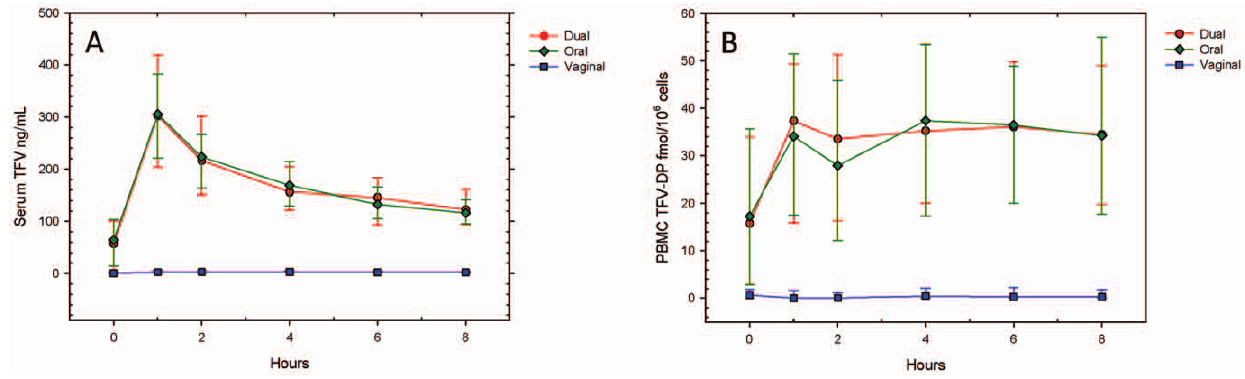
Figure 2. Serum TFV and TFV-DP concentration versus time. Serum TFV (panel A) and PBMC TFV-DP (panel B) concentration versus time plots are shown for the observed 8 hour interval following a dose in clinic according to dosing regimen. Median with asymmetric upper and lower quartiles is shown. Values are only for the 70 US participants where all 6 PK samples were collected.